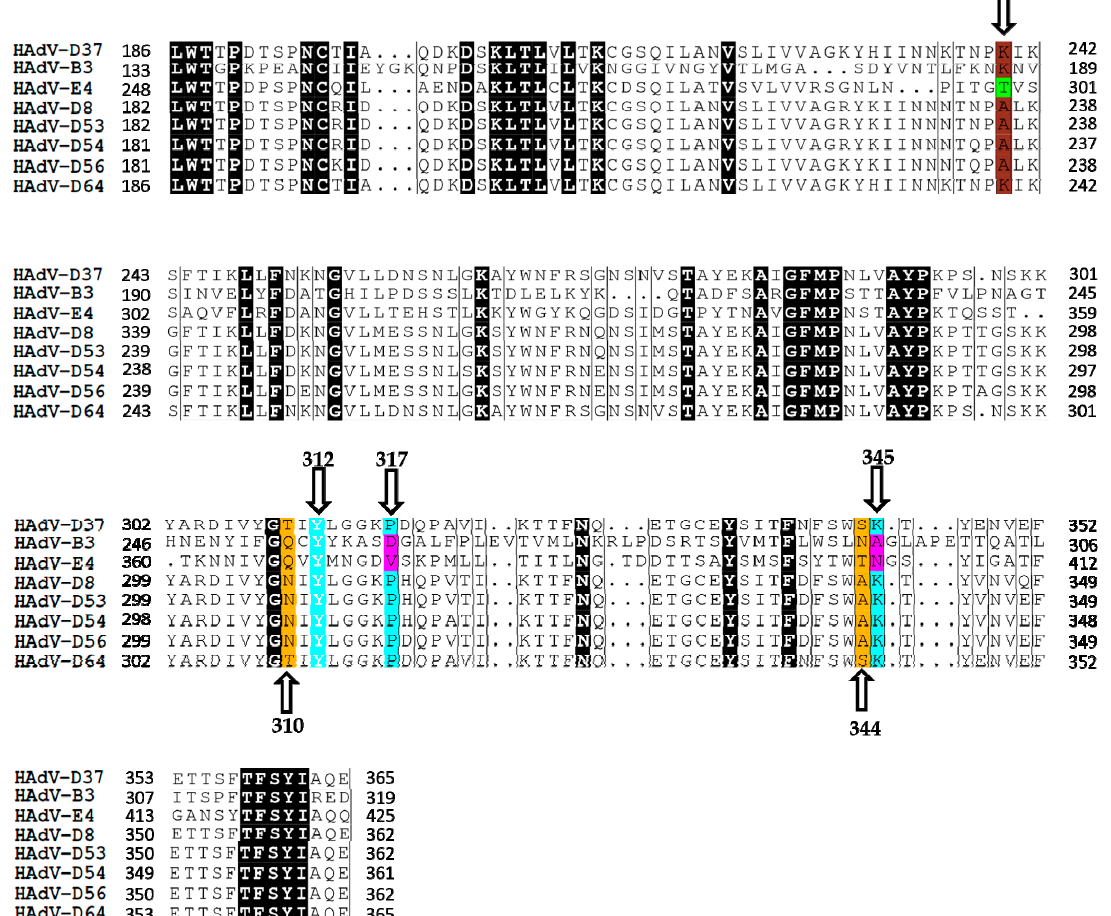
Figure 1. Multiple sequence alignment of the fiber knobs of epidemic keratoconjunctivitis (EKC)- and pharyngoconjunctival fever (PCF)- causing HAdVs. EKC- and PCF-causing HAdVs contain highly and partially conserved critical sialic acid (SA)-binding residues, respectively. Residues highlighted in cyan with white texts represent conserved SA-binding residue (Tyr312) among all ocular HAdVs. Residues highlighted in cyan with black texts represent conserved SA-binding residues (Pro317 and Lys345) among all EKC-causing HAdVs fiber knobs and these residues are not conserved (highlighted in pink) in HAdV-B3 and -E4 fiber knobs. Residues at 310 and 344 on HAdV-D37 mediate contacts with SA via water-mediated hydrogen bonds and these residues either partially or not conserved among all ocular HAdVs (highlighted in yellow). The crucial residue (lysine or alanine) at 240 is conserved (highlighted in brown) in the fiber knobs of all ocular HAdVs except for HAdV-E4 (highlighted in green). Amino acid start positions are according to the HAdV-D37 sequence (accession no. DQ900900).